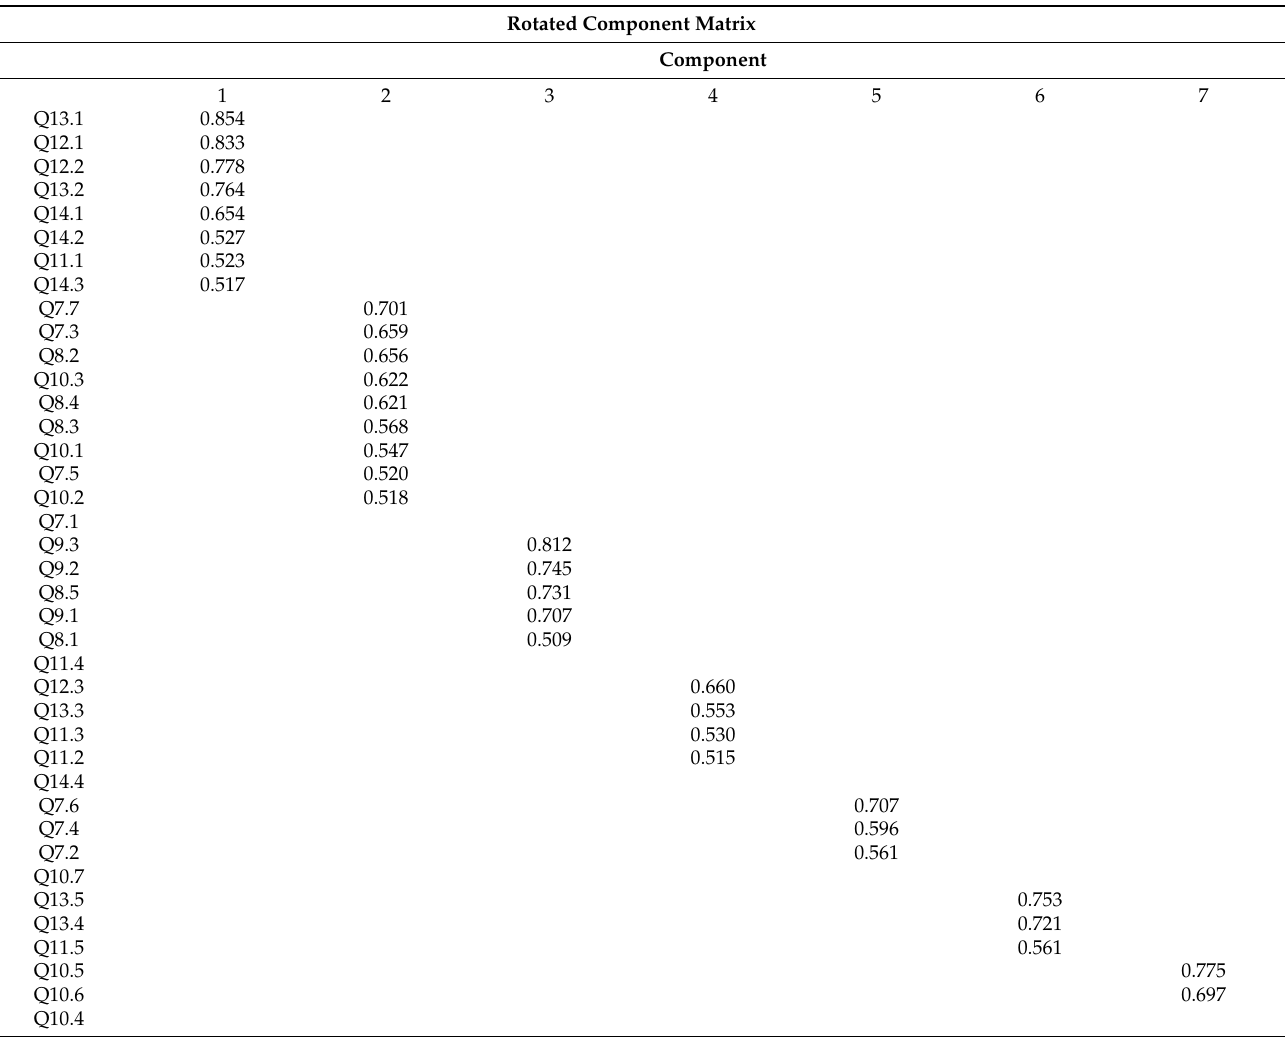
Table 12. Exploratory factor analysis for the university library space user experience questionnaire: rotated component